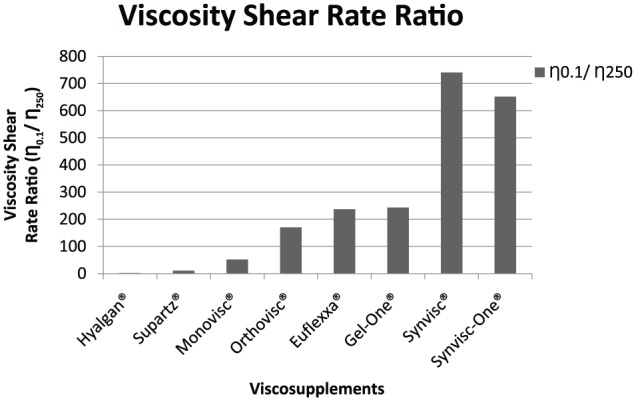
Viscosity shear rate ratio (η0.1/η250) of different viscosupplements.